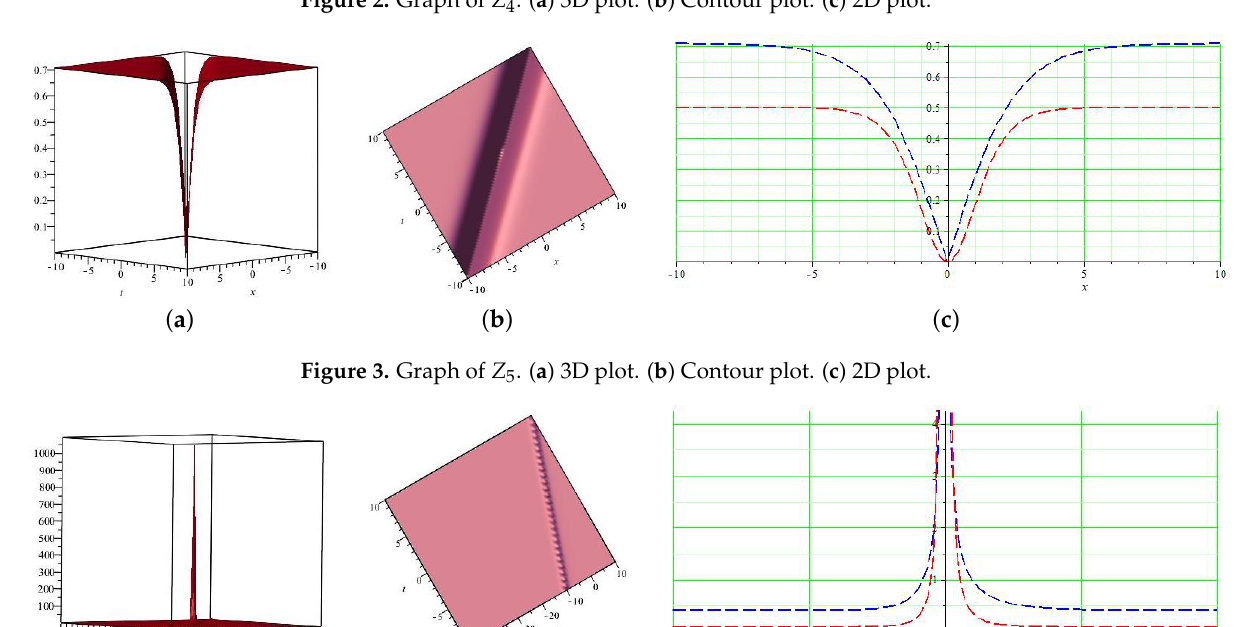
Figure 2. Graph of Z 4 . ( a ) 3D plot. ( b ) Contour plot. ( c ) 2D plot.